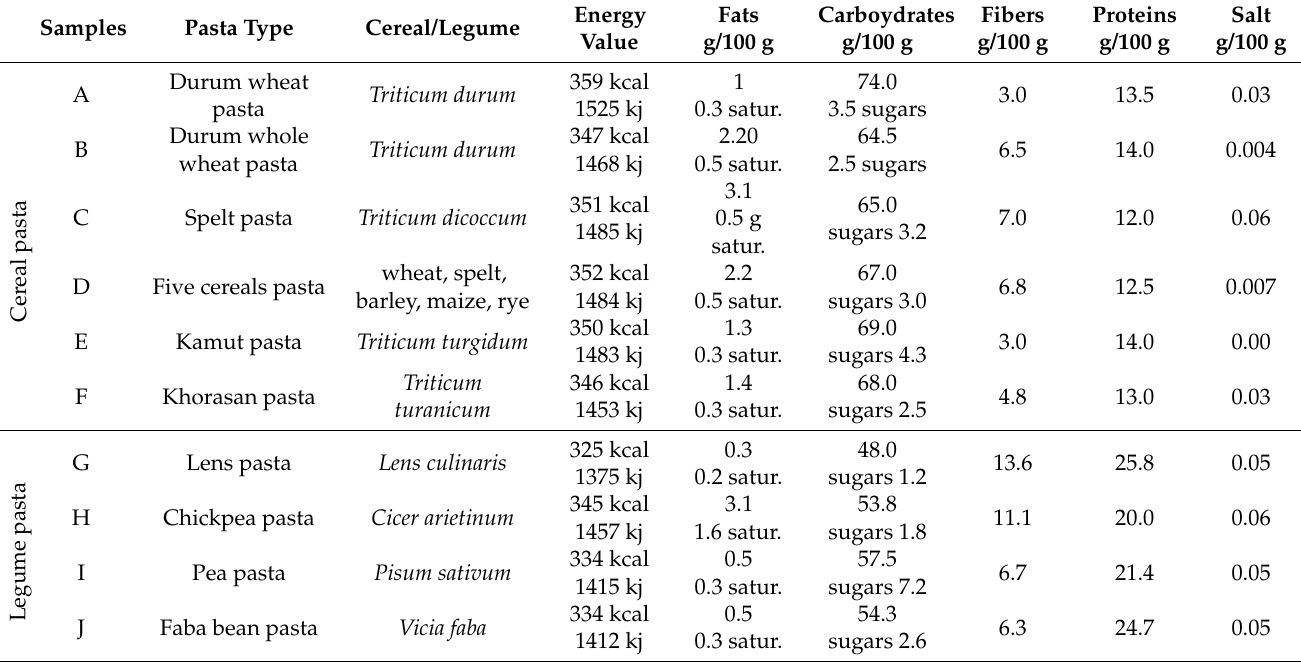
Table 1. Nutrition facts of the ten different types of commercial Italian macaroni pasta used in the tests. Samples Pasta